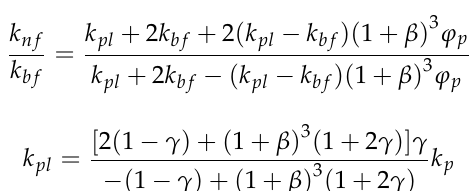
Figure 8. Variations of Al 2 O 3 -water nanofluids